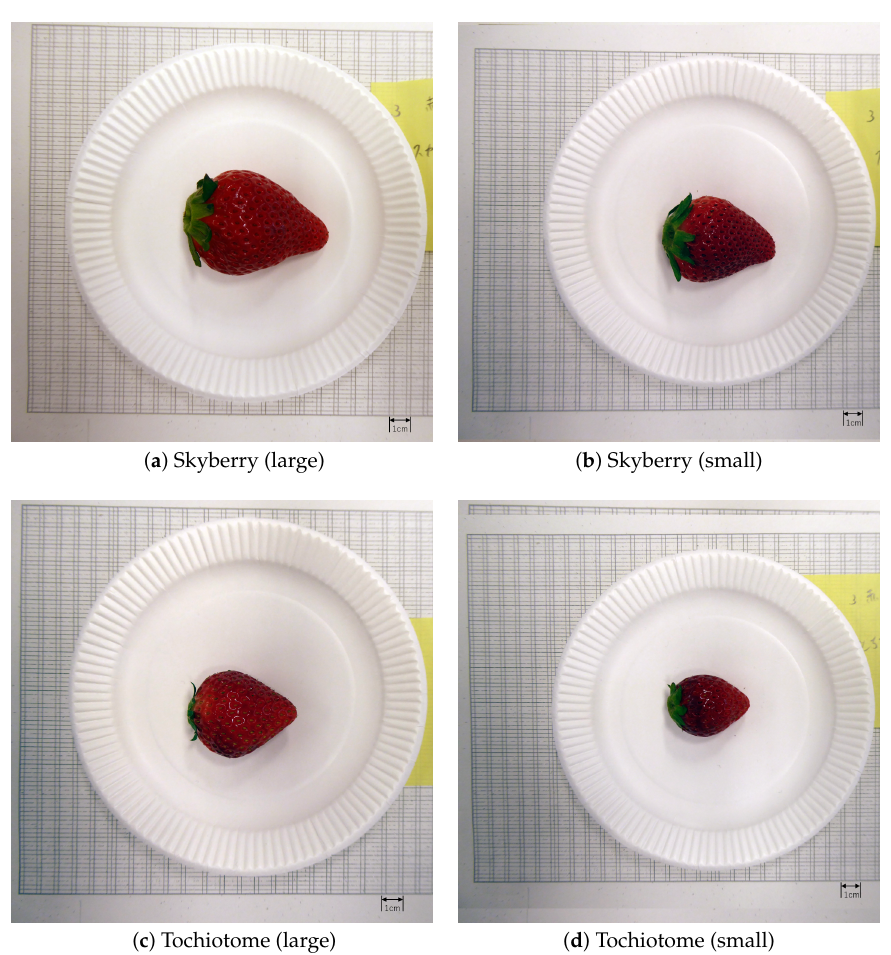
Figure 3. Examples of the strawberries eaten by the participants. These figures are listed as ( a ) Sky- berry (large size), ( b ) Skyberry (small size), ( c ) Tochiotome (large size), and ( d ) Tochiotome (small size),